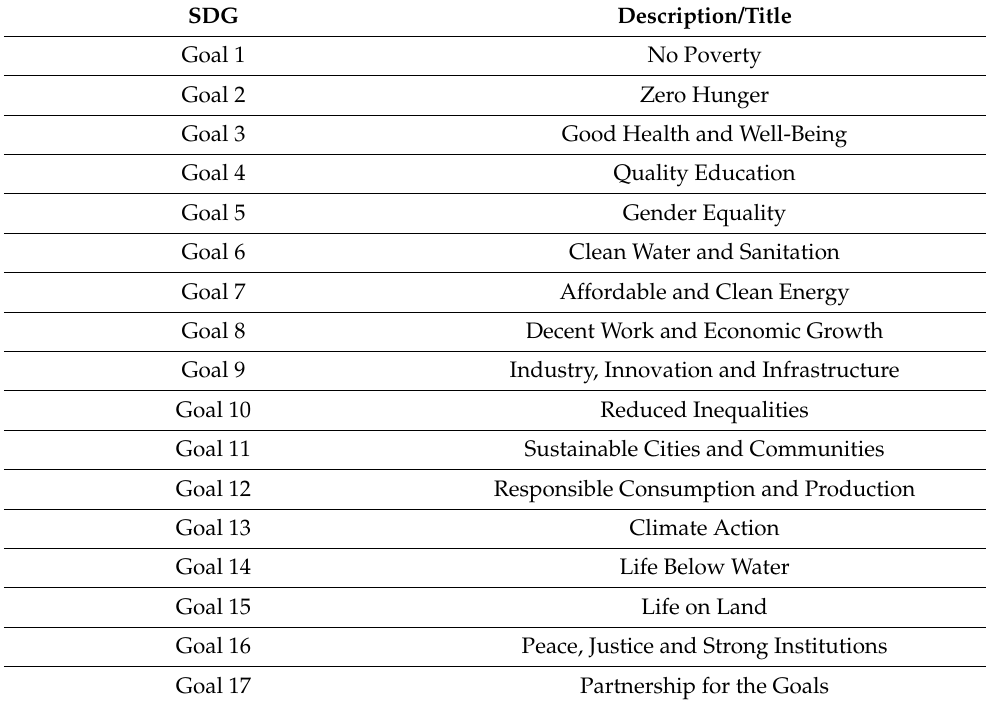
Table 11. The UN